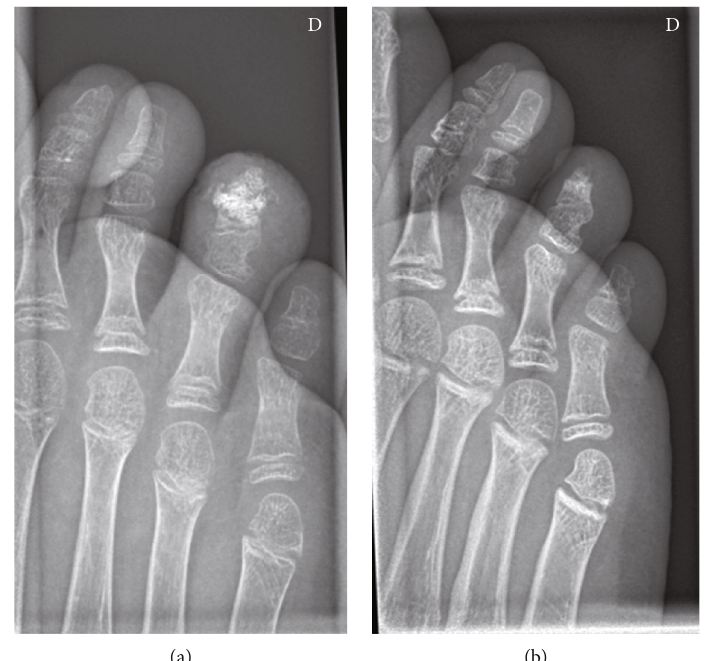
Figure 5: (a) X-ray demonstrating the lyophilized bone graft three week after the intervention. (b) X-ray demonstrating the complete incorporation and remodeling of the graft one year after the